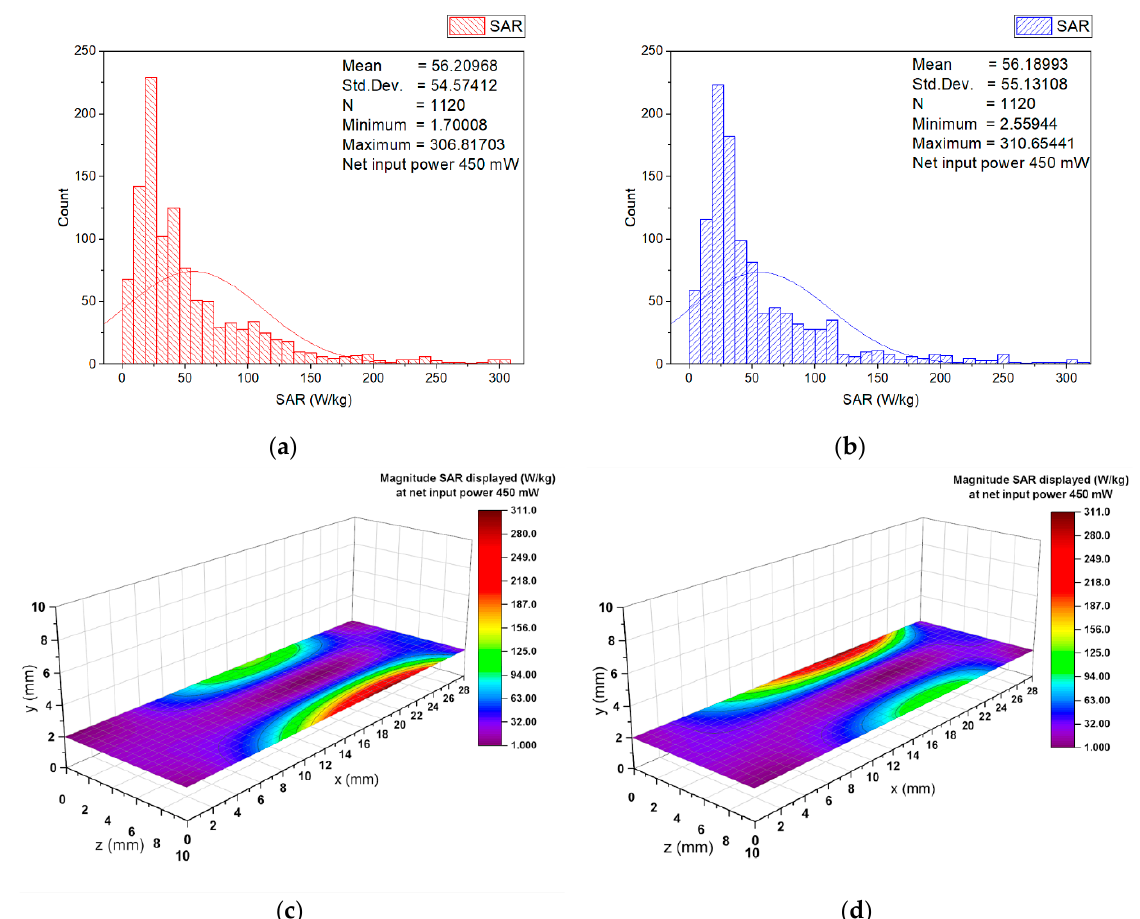
Figure 6. Histograms and descriptive statistics of SAR distribution for the erythrocyte suspensions in the layer with the highest SAR values at net input power of 450 mW: ( a ) left cuvette; ( b ) right cuvette; ( c ) left cuvette color-scale visualization of the SAR distribution; ( d ) right cuvette color-scale visualization of the SAR distribution.